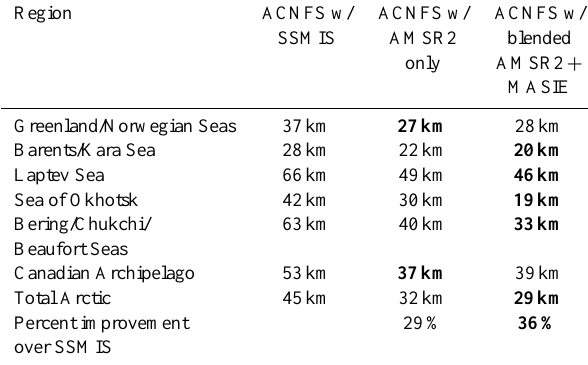
Table 1. Regional mean distance differences (km) between the NIC ice edge and 6h ACNFS forecasts initialized from SSMIS, AMSR2 only and blended AMSR2 + MASIE. Analysis is done for the time period July 2012–July 2013. The bold numbers denote the smallest mean distance error between the assimilation test cases. The bot- tom row shows the total Arctic percent improvement from each ice forecasting system compared to using SSMIS assimilation